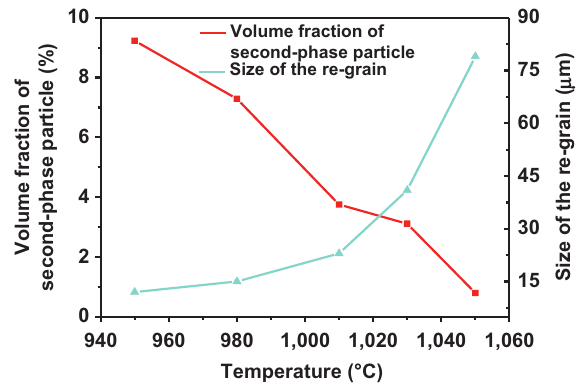
Figure 11: Relationships between the microstructural parameters and the temperature at the strain rate of 0.001 s − 1